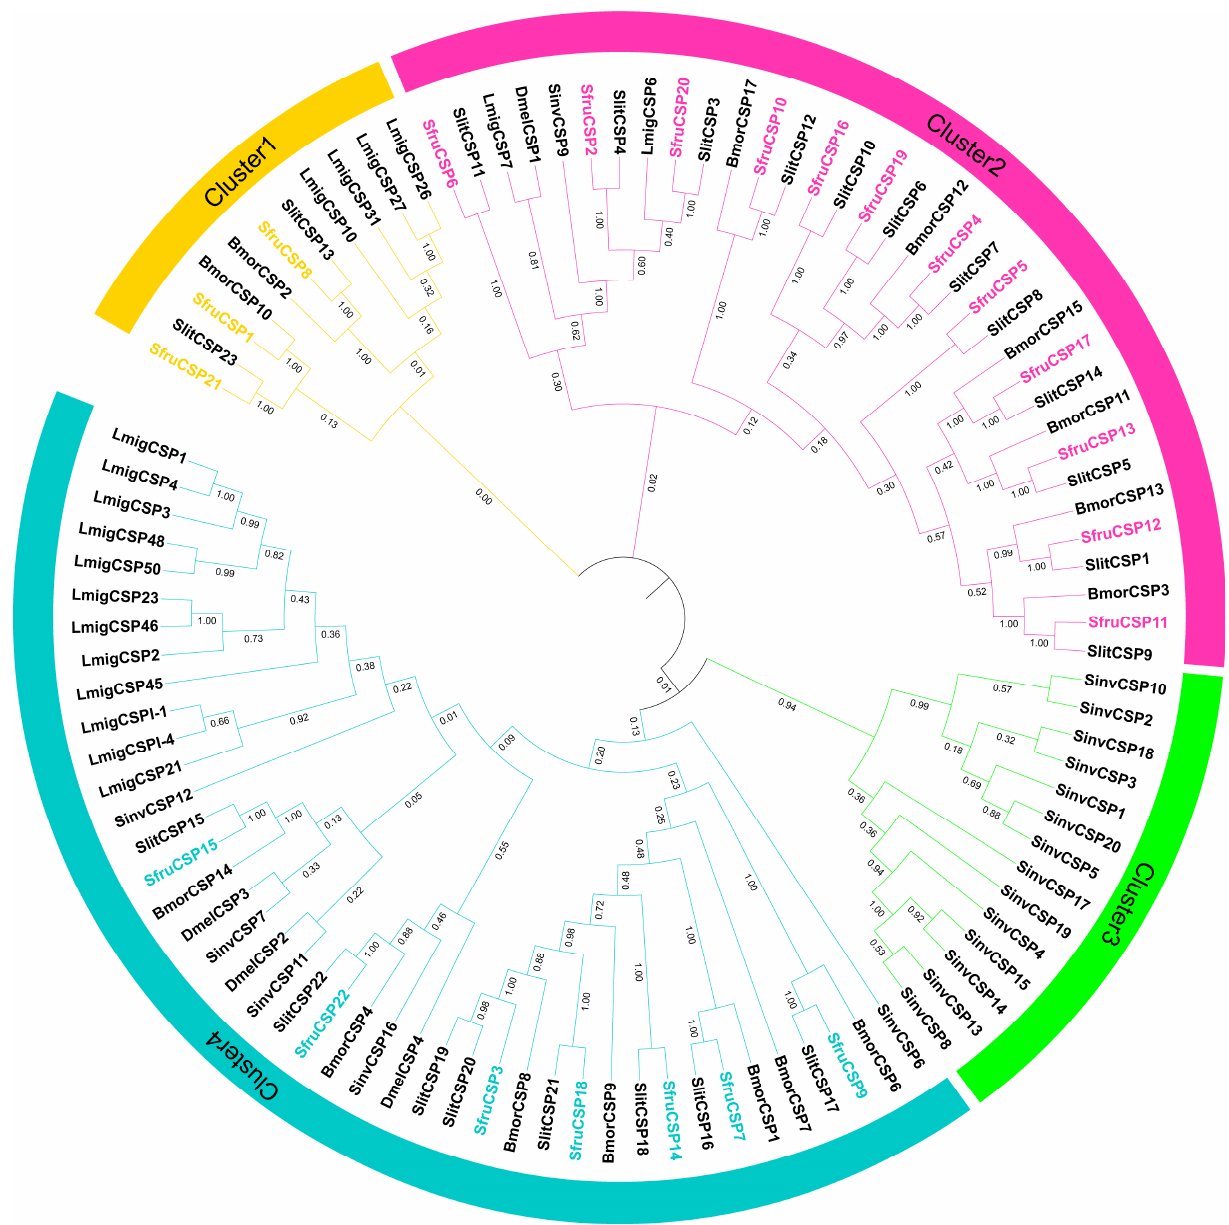
Figure 2. Phylogenetic analysis of CSP representatives from six species. The prefixes Sfru, Slit, Bmor, Lmig, Dmel, and Sinv denote CSP proteins from S. frugiperda, S. litura, B. mori, L. migratoria, D. melanogaster, and S. invicta , respectively. The SfruCSP genes are binned into various clusters based on the homology among CSP representatives.